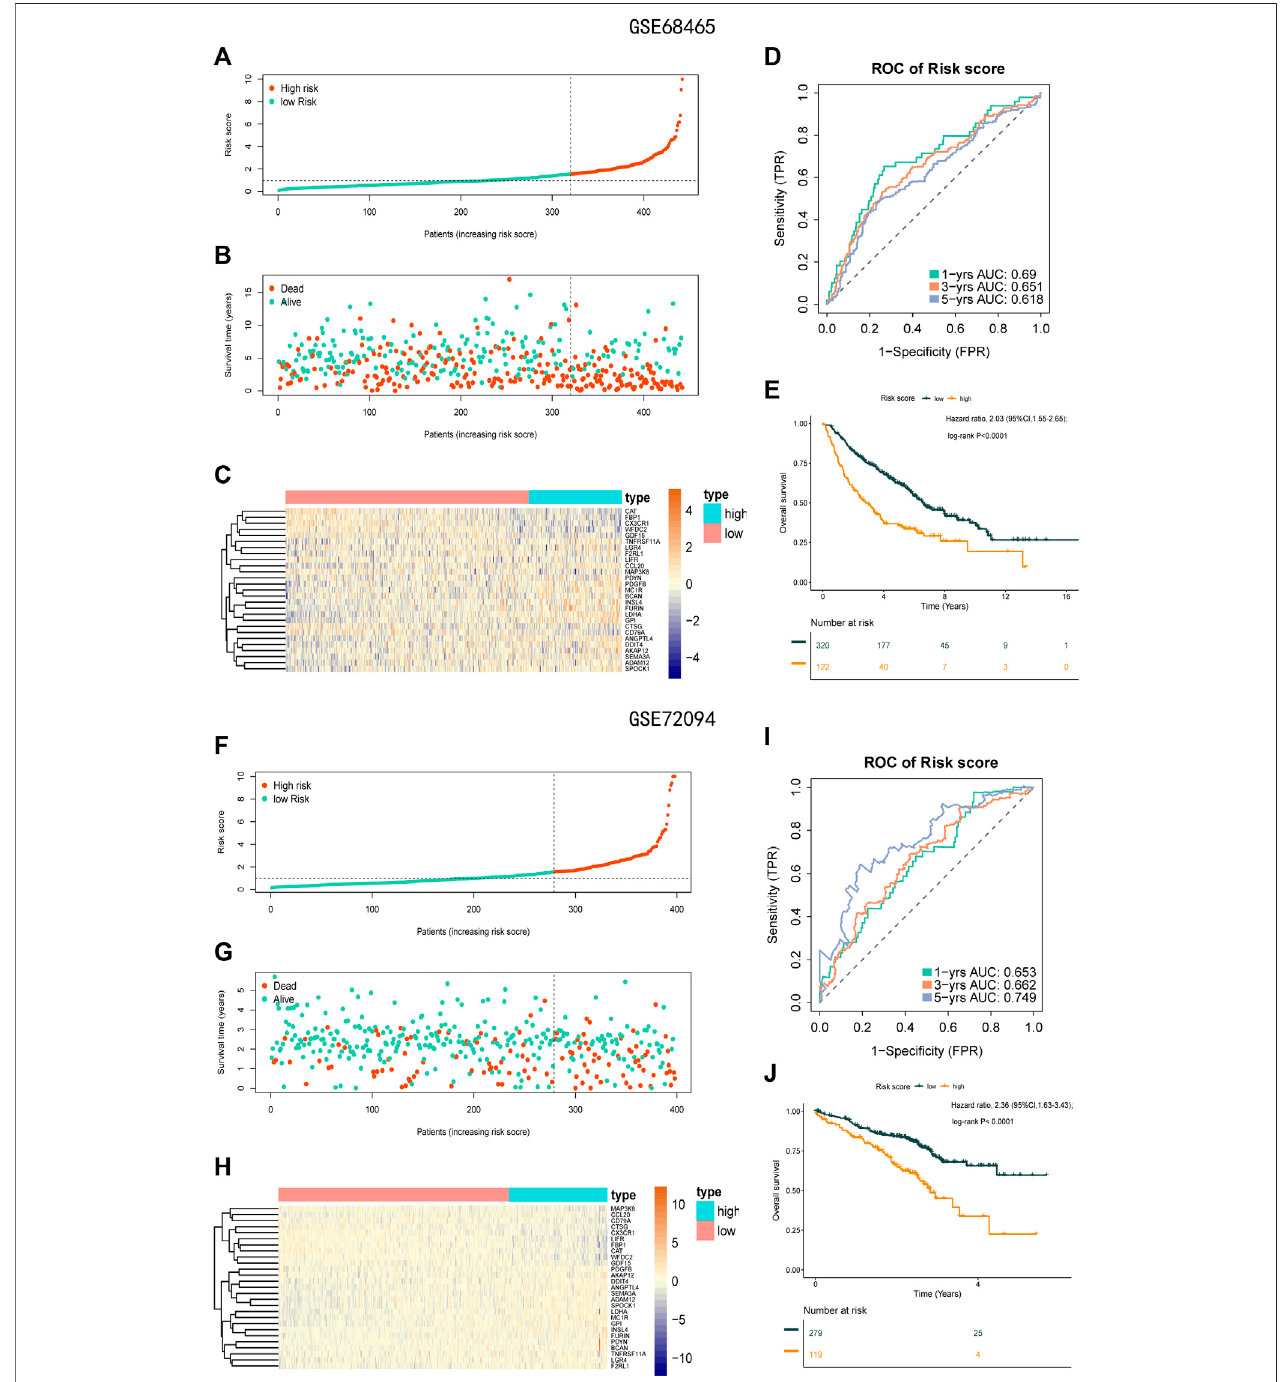
FIGURE 7 | Prognostic analysis of the 27-gene signature model in the validation sets GSE68465 and GSE72094. (A) Distribution of risk score for the GSE68465. (B) Patternsofthesurvivaltimeandsurvivalstatusbetweenthehigh-riskandlow-riskgroupsforGSE68465. (C) Heatmapsofthe27prognosticgenesforeachpatientin GSE68465. (D) Time-related ROC analysis proved the prognostic performance of the risk score in the GSE68465. (E) Kaplan-Meier survival curve of the patients in the high risk score and low risk score groups for OS in the GSE68465. (F) Distribution of risk score for the GSE72094. (G) Patterns of the survival time and survival statusbetweenthehigh-riskand low-risk groupsforGSE72094. (H) Heatmaps ofthe27prognostic genesforeach patient inGSE72094. (I) Time-related ROCanalysis proved the prognostic performance of the risk score in the GSE72094. (J) Kaplan-Meier survival curve of the patients in the high-risk and low-risk groups for OS in the